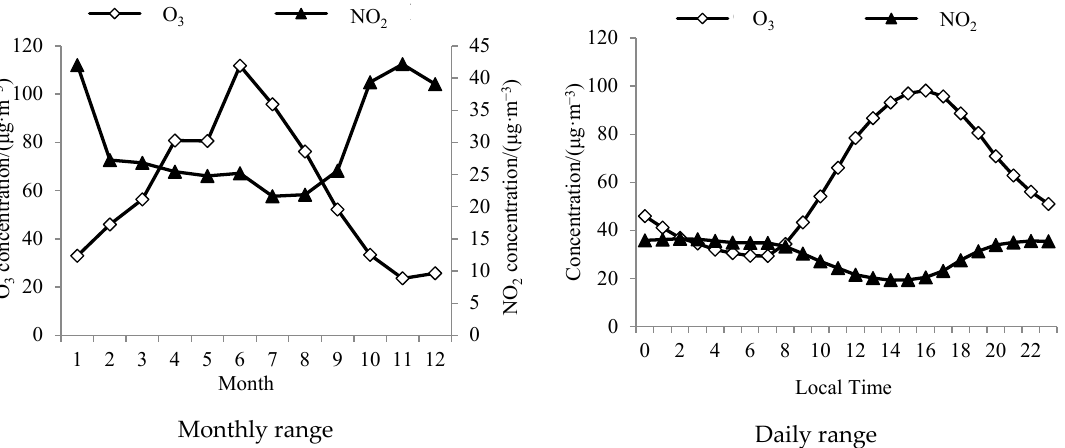
Figure 9. Annual (monthly averages) and daily (hourly values) variations in O 3 and NO 2 concentra- tions.